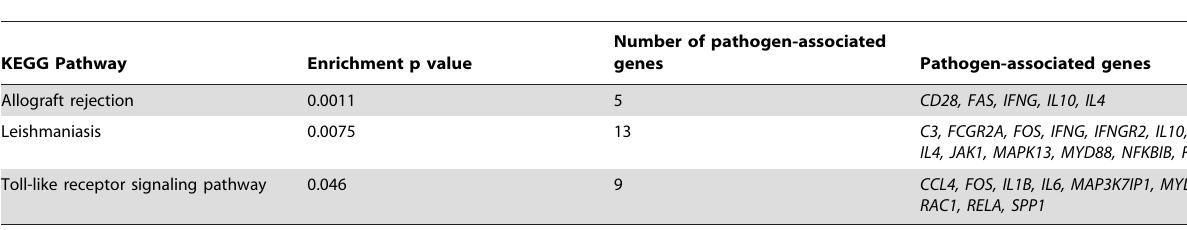
Table 2. KEGG pathways enriched with genes which correlated with pathogen